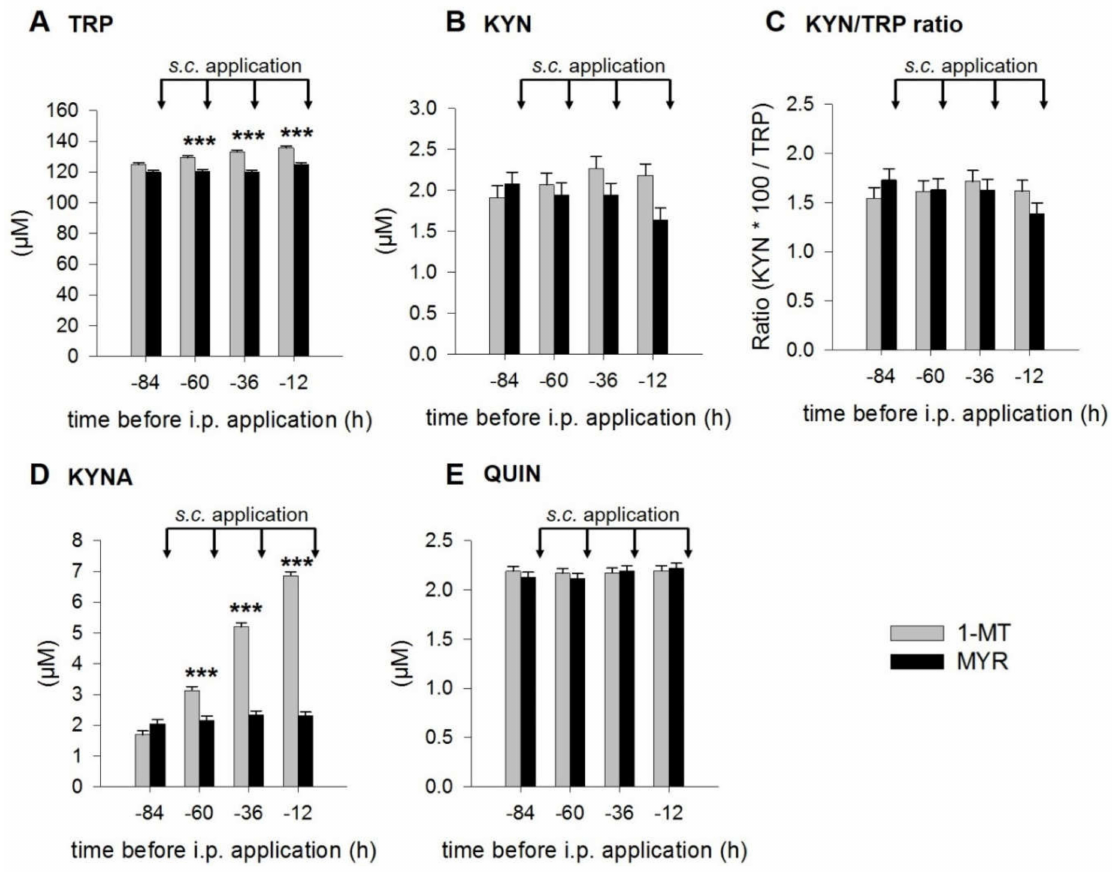
Figure 1. Effects of repeated s.c. 1-MT applications on plasma TRP ( A ), KYN ( B ), KYN/TRP ratio ( C ), KYNA ( D ) and QUIN ( E ) before LPS application. Pre-treatment with MYR was used as a control. TRP and its metabolites were measured using MS/MS and the KYN/TRP ratio was used as a marker for IDO1 activity. The s.c. 1-MT or MYR applications (indicated by black arrows) were injected directly after each blood sampling. The results are presented as LS-means ± SE. Significant differences between the 1-MT- and MYR-pre-treated groups were calculated using the Tukey–Kramer test and are indicated for each time point. 1-MT: n = 24; MYR: n = 23; *** p <